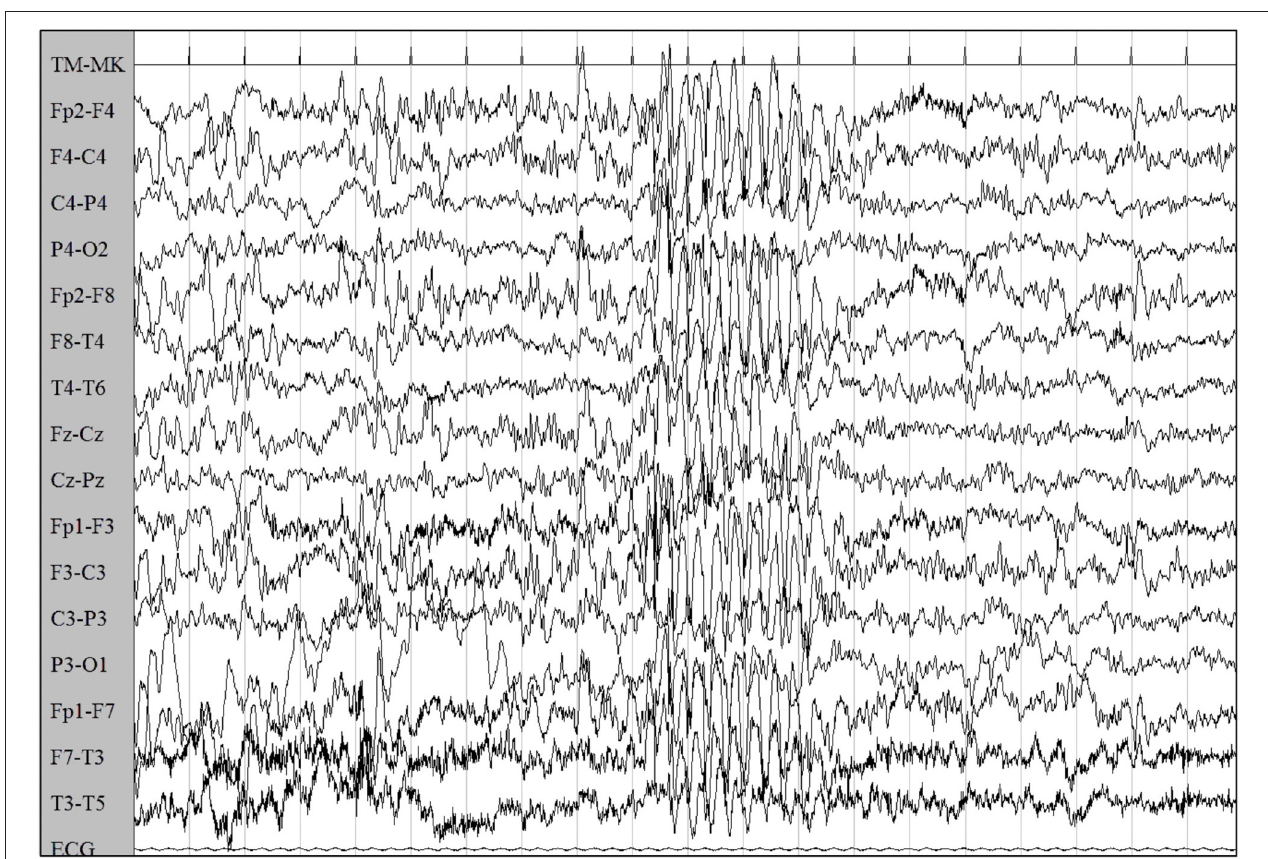
FIGURE 2 | EEG showed synchronous symmetrical irregular 2.5–3Hz spike-and-wave sequences, facilitated by hyperventilation, consistent with atypical absence